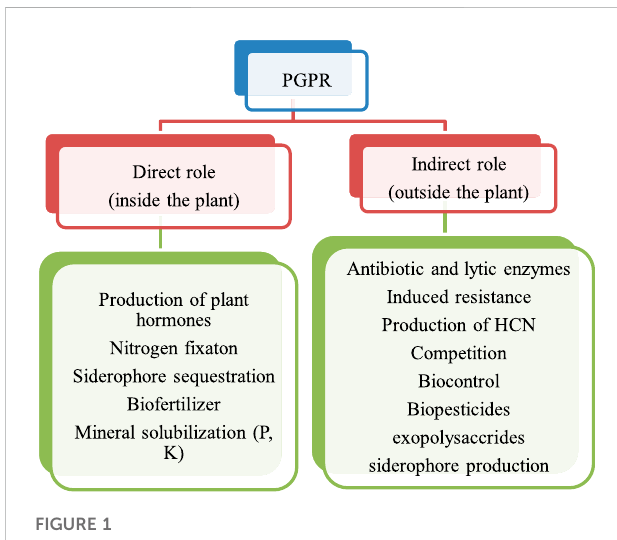
FIGURE 1 Types of PGPR activities in the rhizosphere (Kundan et al., 2015; Nath et al., 2018).